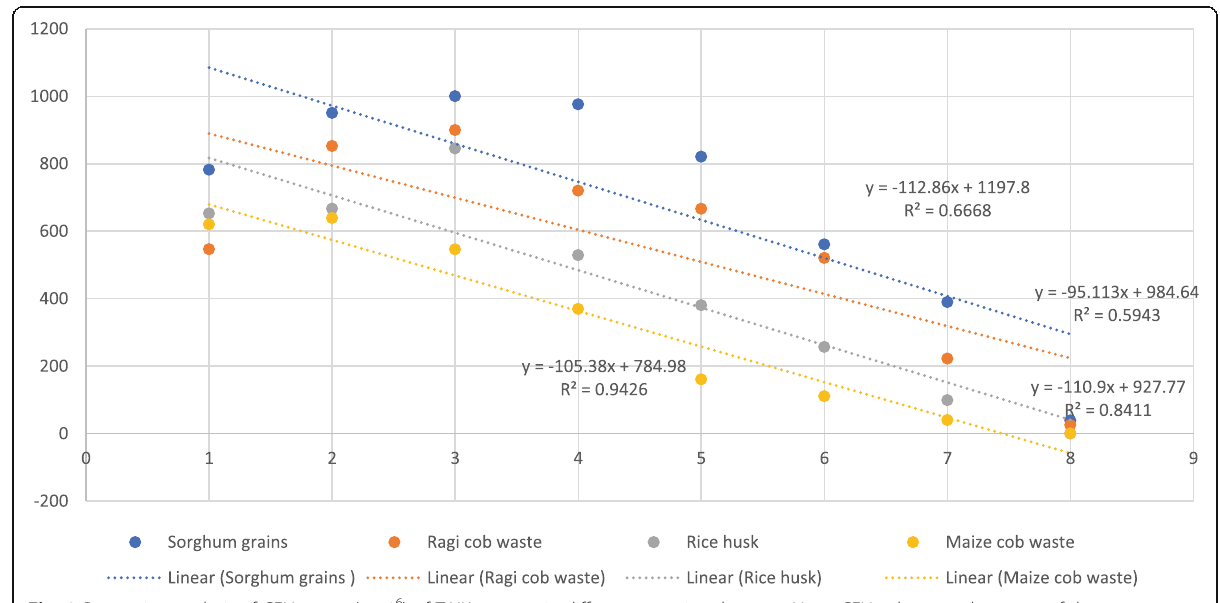
Fig. 3 Regression analysis of CFU count (× 10 6 ) of TAIK1 grown in different organic substrates. Note: CFU values are the mean of three